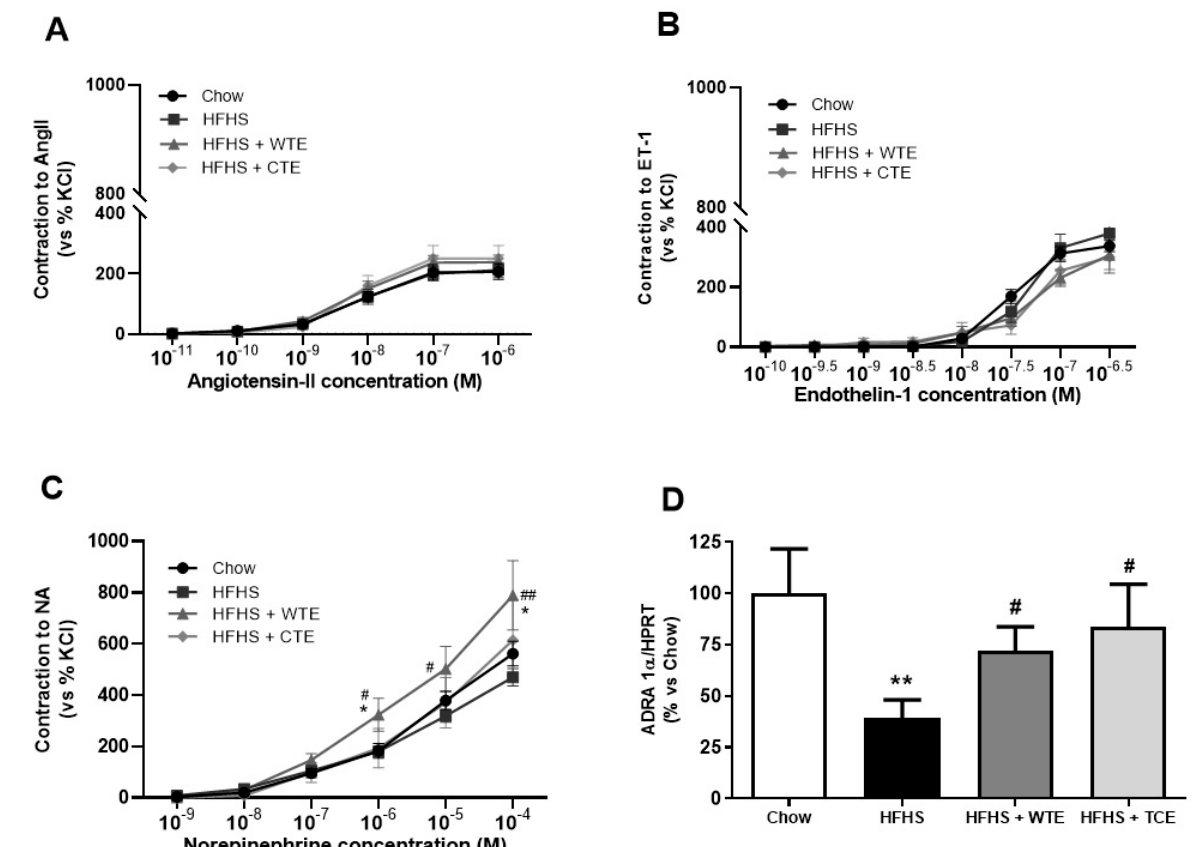
Figure 6. Contraction of the abdominal aortic rings to angiotensin-II (AngII) (10 − 11 –10 − 6 M) ( A ), endothelin-1 (ET-1) (10 − 10 –10 − 6,5 M) ( B ), noradrenaline (NA) (10 − 9 –10 − 4 M) ( C ), and the gene expression of alpha-1-adrenergic receptor (ADRA 1 α ) ( D ) of mice fed a standard diet (Chow), a high-fat diet/sucrose diet (HFHS), a high-fat diet/sucrose diet supplemented with White Tea Extract (HFHS + WTE), or a high-fat diet/sucrose diet supplemented with Tea Complex Extract (HFHS + TCE). * p < 0.05; ** p < 0.01 vs. chow. # p < 0.05; ## p < < 0.01 vs. HFHS. The values are represented as the mean ± S.E.M; n = 7–10 samples/experimental group.